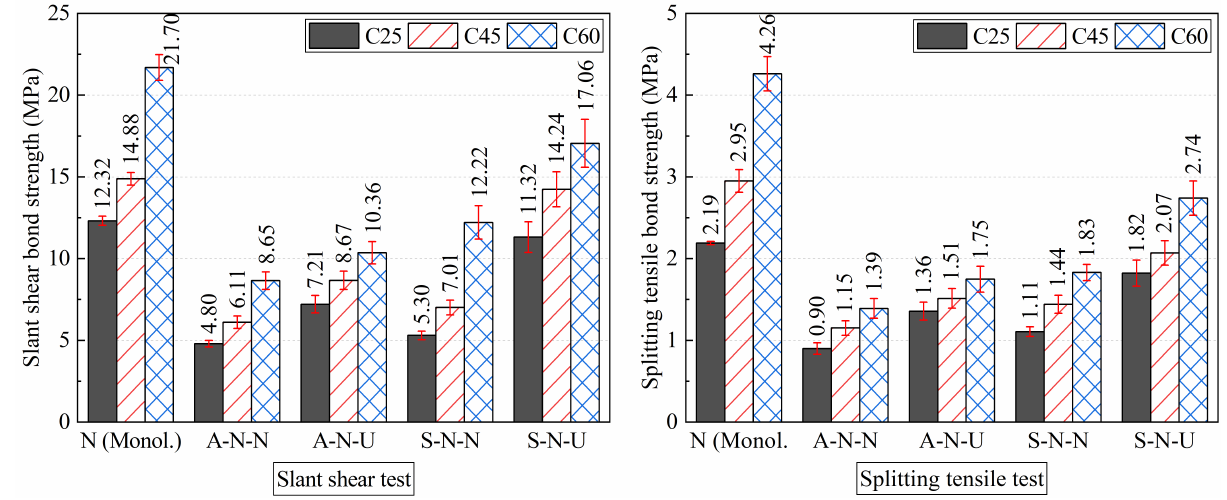
Figure 4. Experimental results of slant shear and splitting tensile tests. Nomenclature: A is the ASD wetting condition; S is the SSD wetting condition; N is the NSC or HSC concrete; U is the